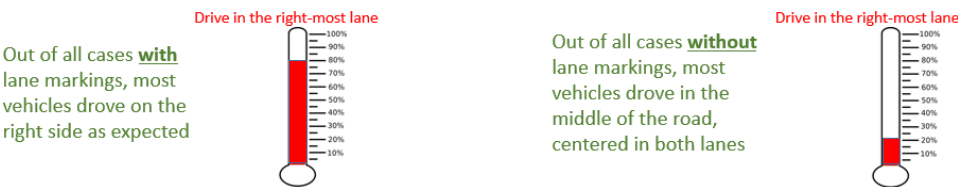
Figure 1. Illustration of a Cognitive Tutorial rule card to help support learning a systematic limitation of the Tesla FSD